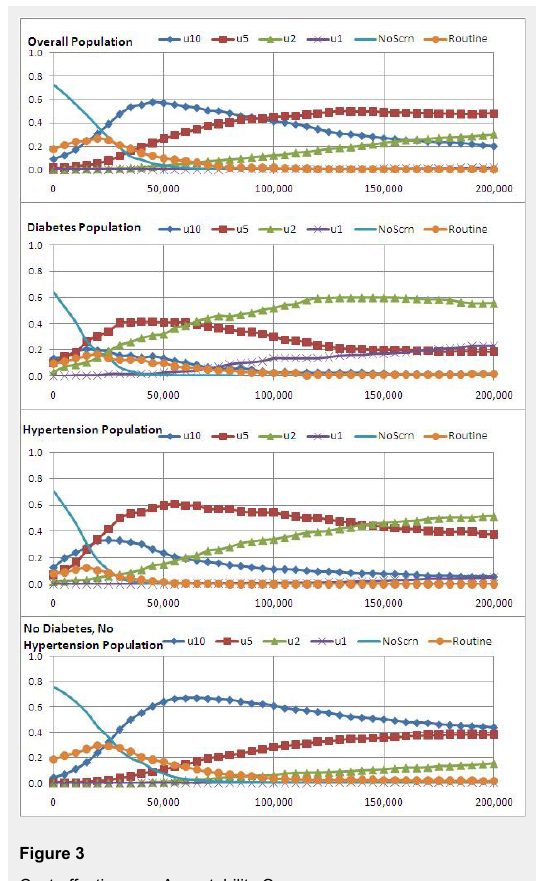
Cost-effectiveness Acceptability Curves. U10: screening at 10-year interval, u5: screening at 5-year interval; u2: screening at 2-year interval: u1 annual screening; Noscrn: No screening scenario; Routine: usual care